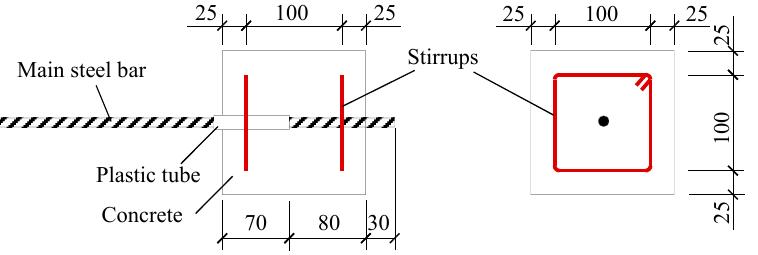
Figure 1. View and reinforcement details of specimens (mm).